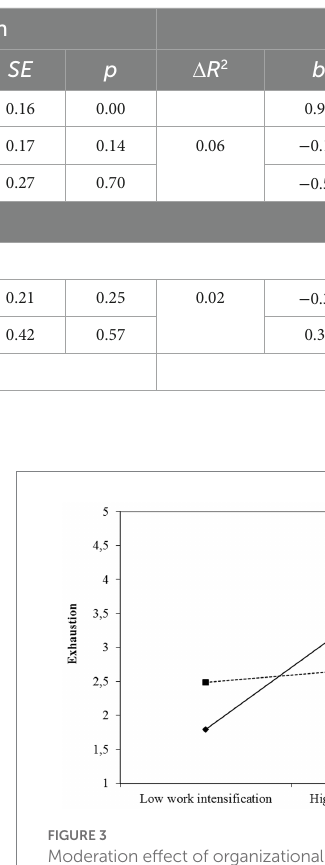
TABLE 4 Regression analyses emotional demands.